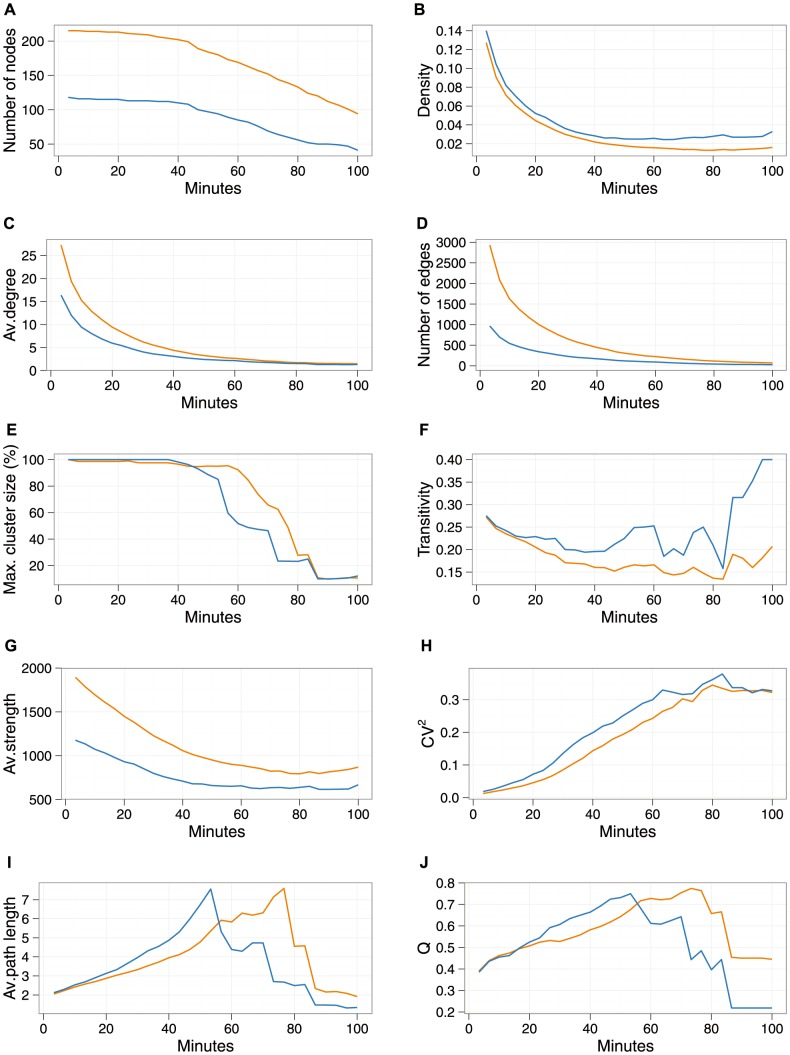
Network statistics on the combined contact data collected during all three school days, for the entire contact graph (orange line) and for the unvaccinated contact graph (blue line).All statistics are calculated for a minimum contact duration (in minutes). As contact duration increases, nodes drop out of the network if they do not have a contact that satisfies the minimum contact duration. (A) Hence, the reduction in the number, V, of nodes. (B) Density of the graph. (C) Average (av.) degree. (D) Number of edges, E. (E) Maximum (max) cluster size, as a fraction of total (maximum) network size. (F) Transitivity (i.e., cluster coefficient). (G) Average (Av.) strength as defined by Barrat [42], where the strength of the node is the total number of CPRs of the node. (H) CV2 of degree. (I) Average (Av.) path length. (J) Modularity, Q, as defined by Reichardt and Bornholdt [53].